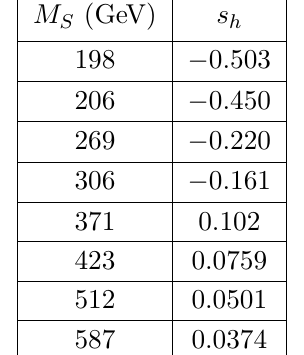
Table 2 . Selected values of the singlet mass and mixing with the lightest